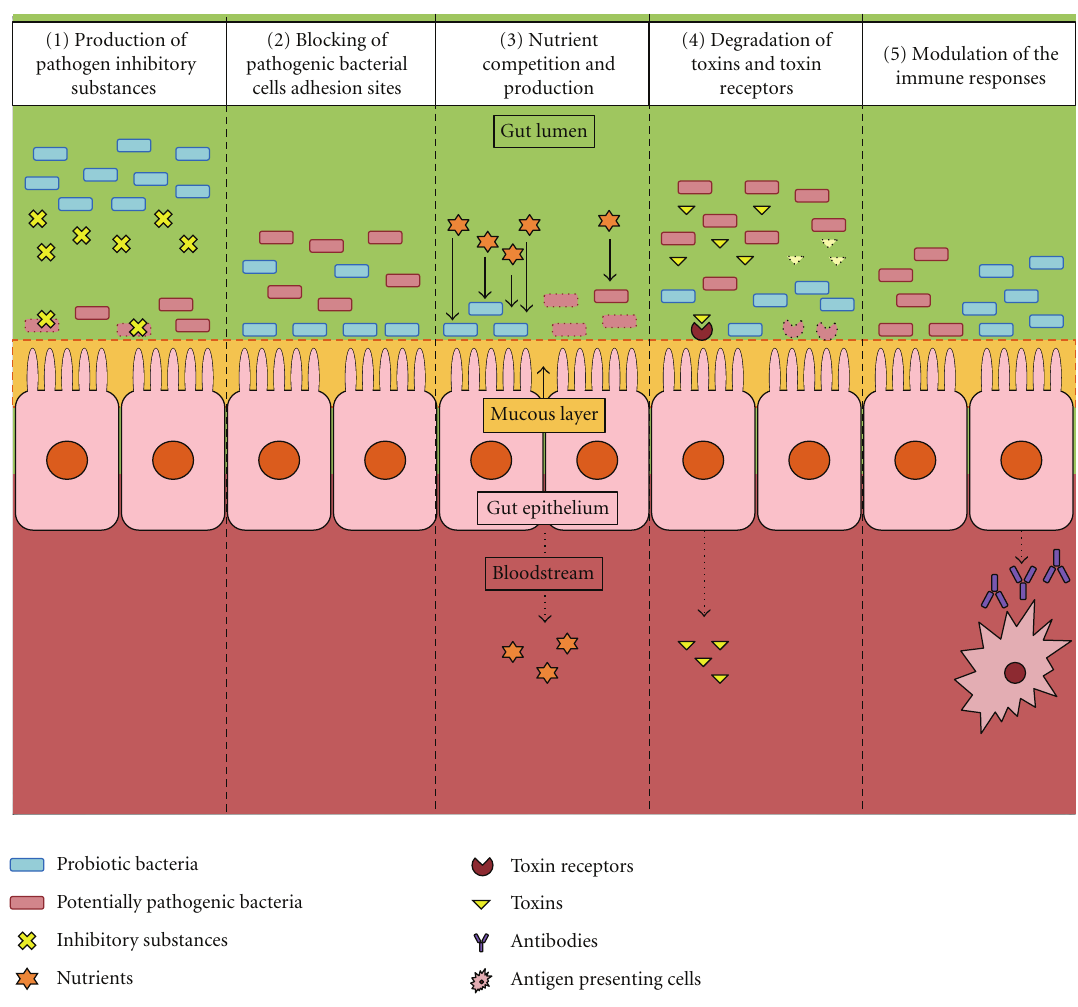
Figure 2: Pathways by which a probiotic can positively influence human health. They can influence human health by (1) production of pathogen inhibitory substances; (2) blocking of pathogenic bacteria adhesion sites; (3) nutrient competition and production; (4) degradation of toxins and toxin receptors; (5) modulation of innate immune